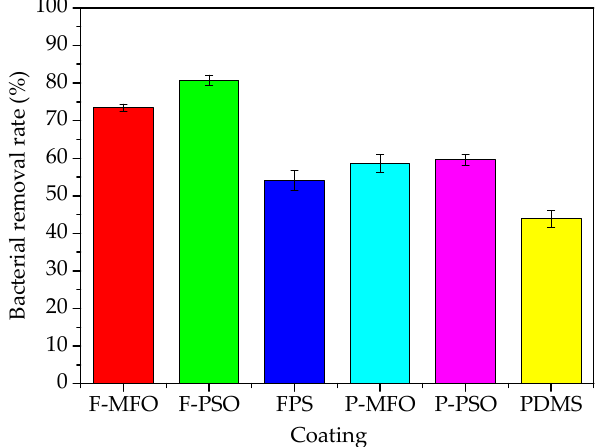
Figure 11. Removal rate of bacteria attached on studied coatings.